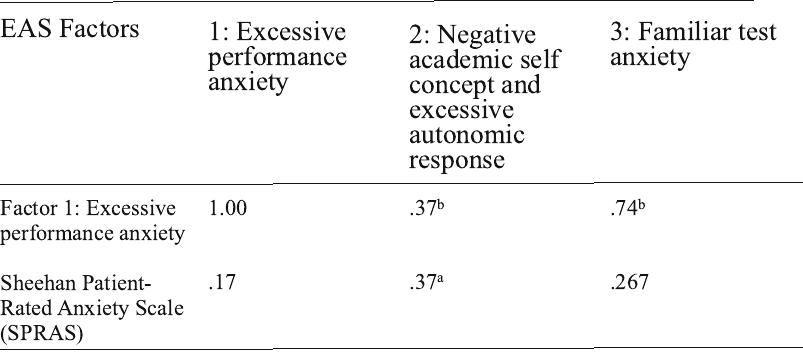
Pearson Product Moment Correlations between factors Scores and Sheehan’s self- report scale